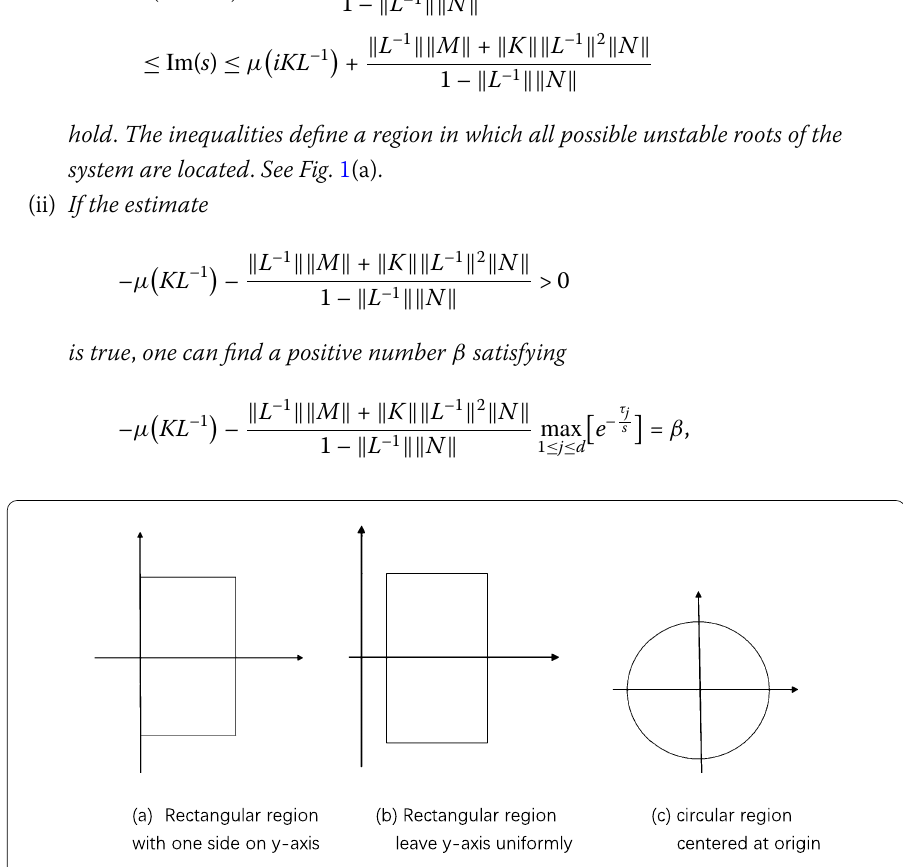
Figure 1 Three possible regions containing unstable